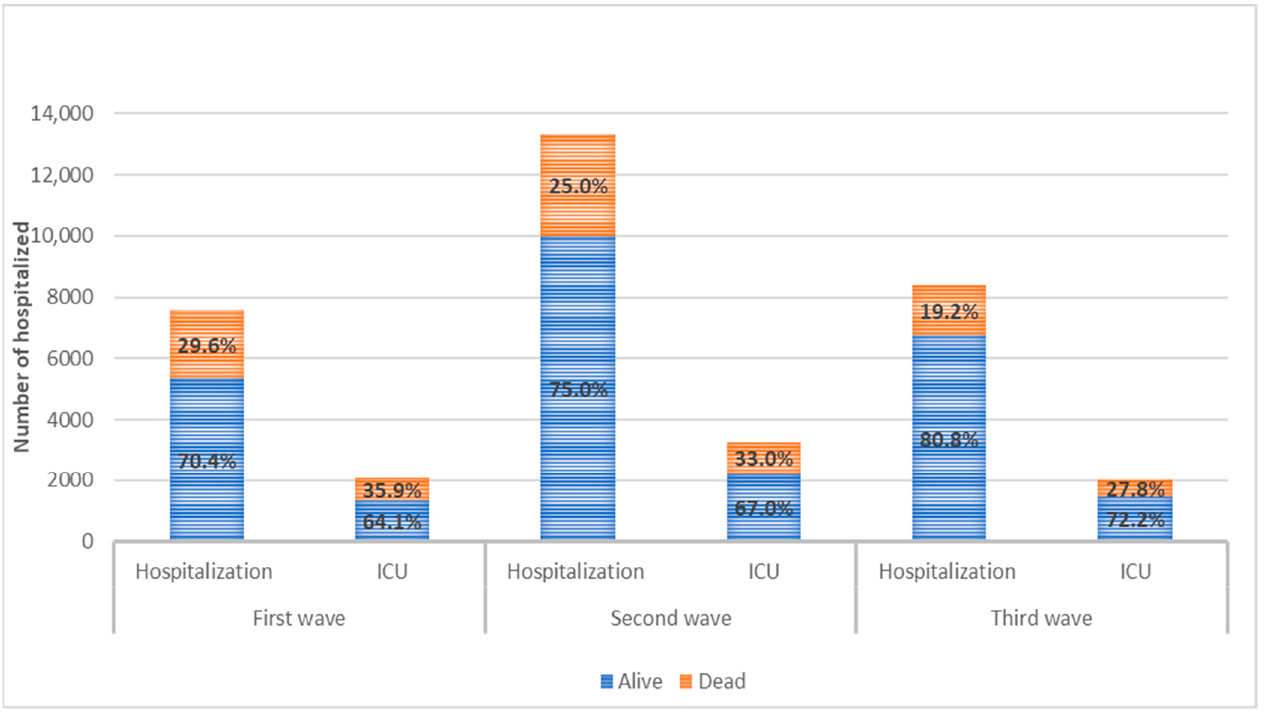
Table 2. Demographic characteristics, comorbid conditions, intensive care unit (ICU) admission, and death from COVID-19 of subjects tested positive for SARS-CoV-2, stratifying by hospitalization and waves.